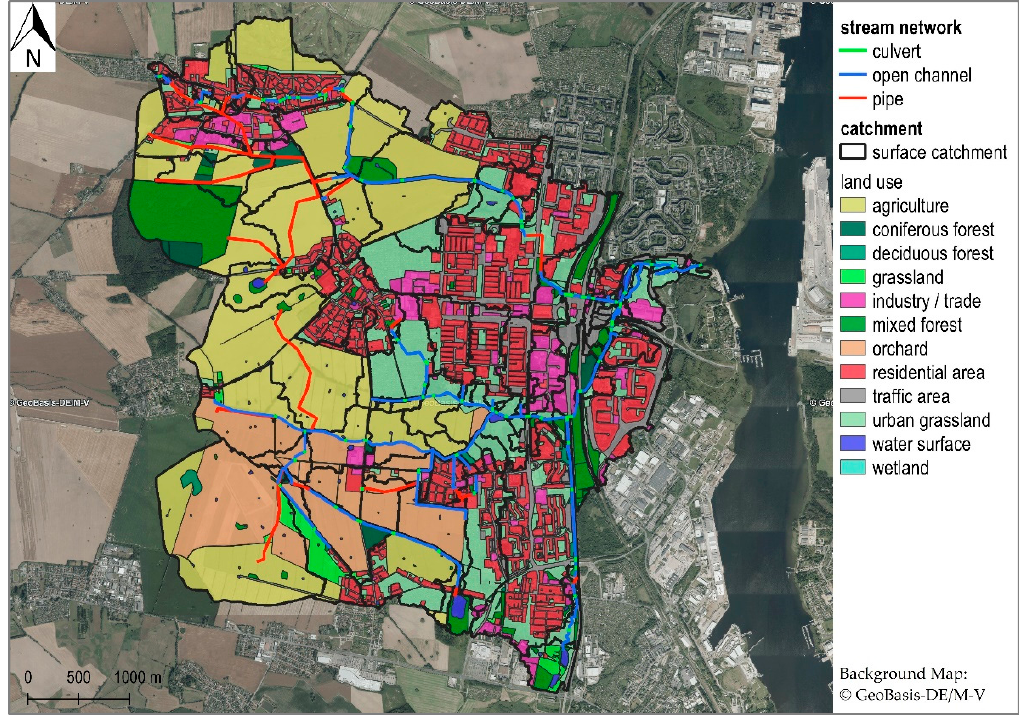
Figure 5. Model subcatchments as intersection of the surface catchments and land use polygons.